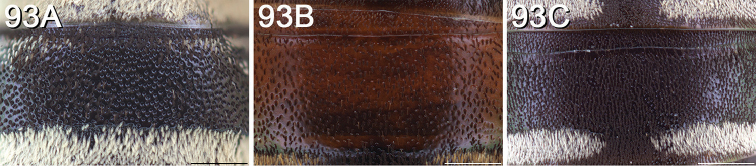
T2 (medial portion in dorsal view) of female A
E.
lectus with punctures coarse and deep B
E.
glabratus with punctures minutes and shallow, and C
E.
inornatus paratype with punctures minute and shallow. Scale bars 0.5 mm.